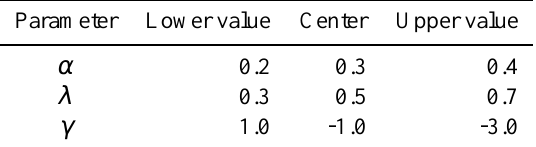
Table 1. Parameter values for the SLA parameter setting exper- iment.